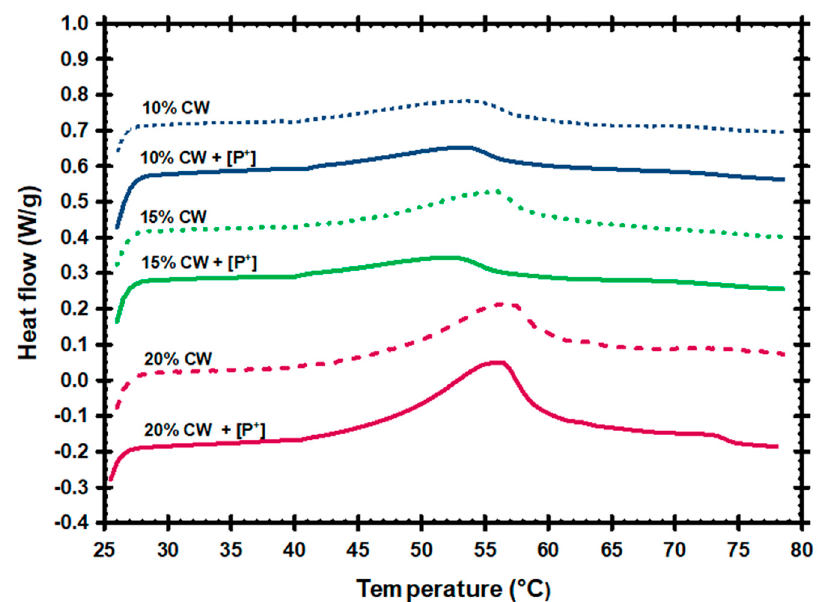
Figure 1. Melting thermograms of oleogels developed with different concentrations of candelilla wax (CW), with and without the addition of phosphorus [P + ]. On the other hand, the results of the rheological studies (i.e., frequency sweeps) that were performed on the oleogels at 40 ◦ C demonstrated the formation of true gels by presenting values of the elastic modulus (G (cid:48) ) greater than those of the viscous modulus (G (cid:48)(cid:48) ) in the entire frequency range (Figure 2), while also having high G (cid:48) values to the order of 10 5 and 10 6 Pascals (Table 1). It was observed that with a higher concentration of